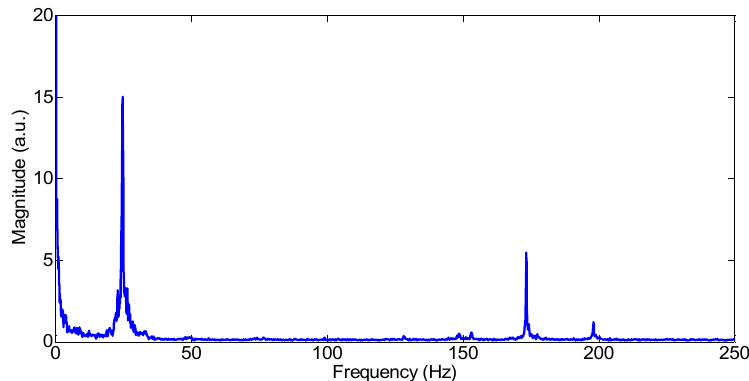
Figure 15. The frequency spectrum showing the primary peak at 24.8 Hz and a peak at the 7th harmonic of 173.4 Hz.